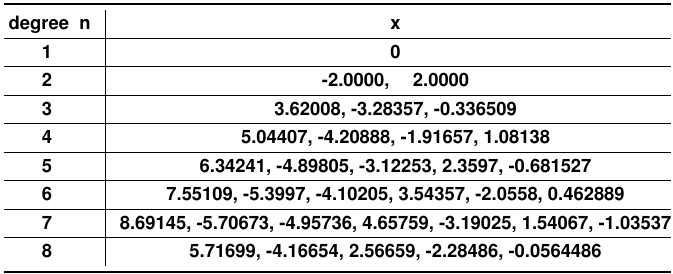
Table 2. Approximate solutions of B n .x;4/ D 0;x 2